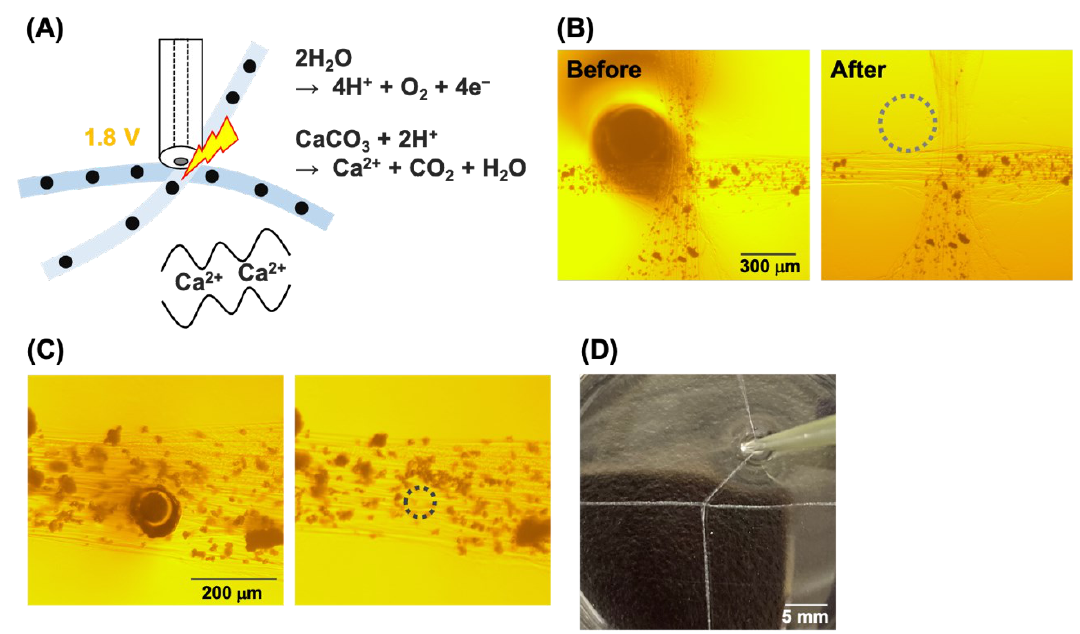
Figure 4. Electrochemical gluing via Ca 2+ : ( A ) Schematic. Black circles indicate CaCO 3 particles. Microphotographs of hydrogel fibers before and after the application of 1.8 V using ( B ) the 300-µm- diameter Pt wire and ( C ) the 50- μ m-diameter Pt disk microelectrode. ( D ) Photograph of electrochemically glued hydrogel fibers.